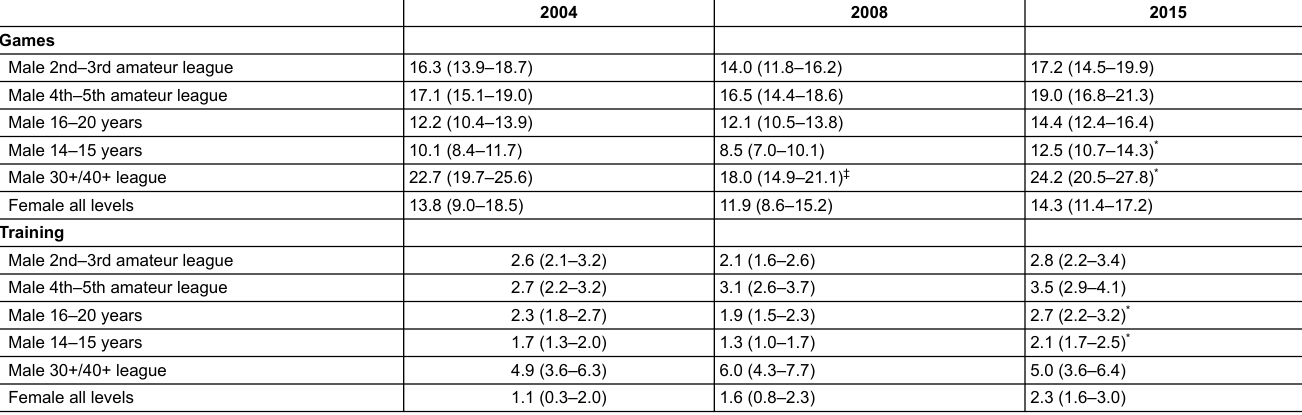
Table 2: Injury incidence during amateur soccer games and training per 1000 hours of playing during the previous 4 weeks, by league (including 95% confidence intervals).